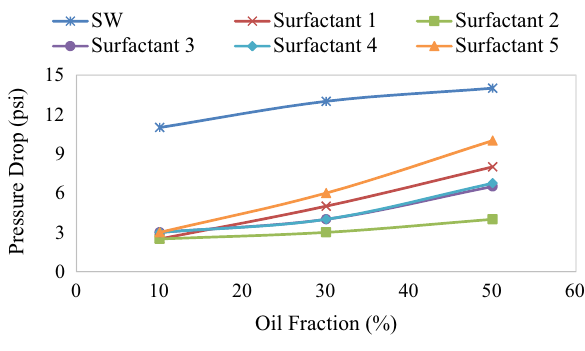
Fig. 4 Emulsification test at 100 °C, and 100 psi